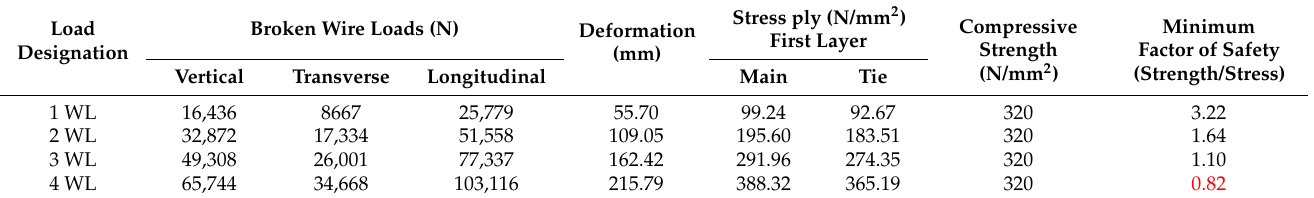
Table 5. Maximum stress in the layer of GFRP cross-arm for broken wire